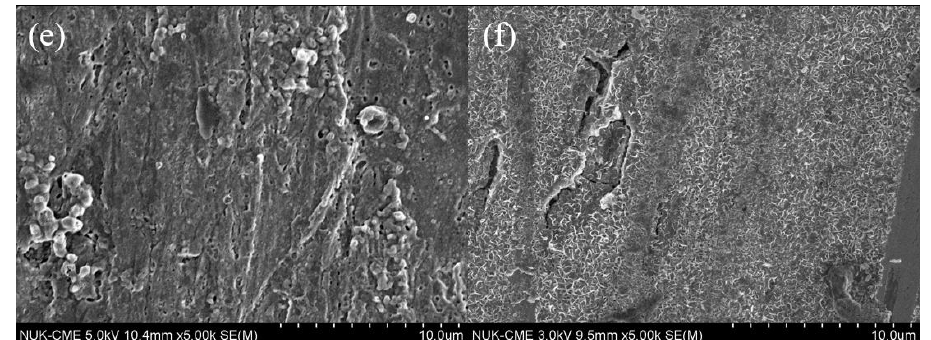
Figure 5. SEM images of SPCC mild steel ( a ); SPAN deposited on mild steels with an AN/DABSA ratio of 10 ( b ), 8.8 ( c ), and 3.3 ( d ); SPAN-deposited with AN/DABSA ratio of 8.8 on mild steel after an AC impedance test in 1 M HCl ( e ), and in 1 M NaCl ( f ) .